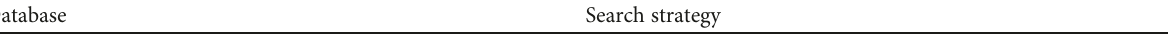
Table 1: Search strategy for